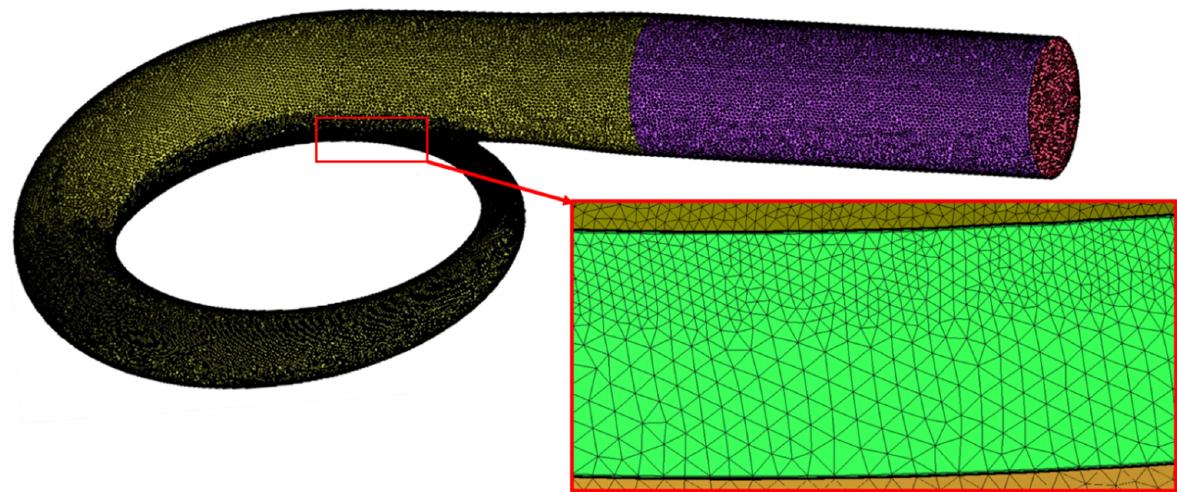
Figure 3. Mesh of a sector of the ported shroud with a cut-plane.